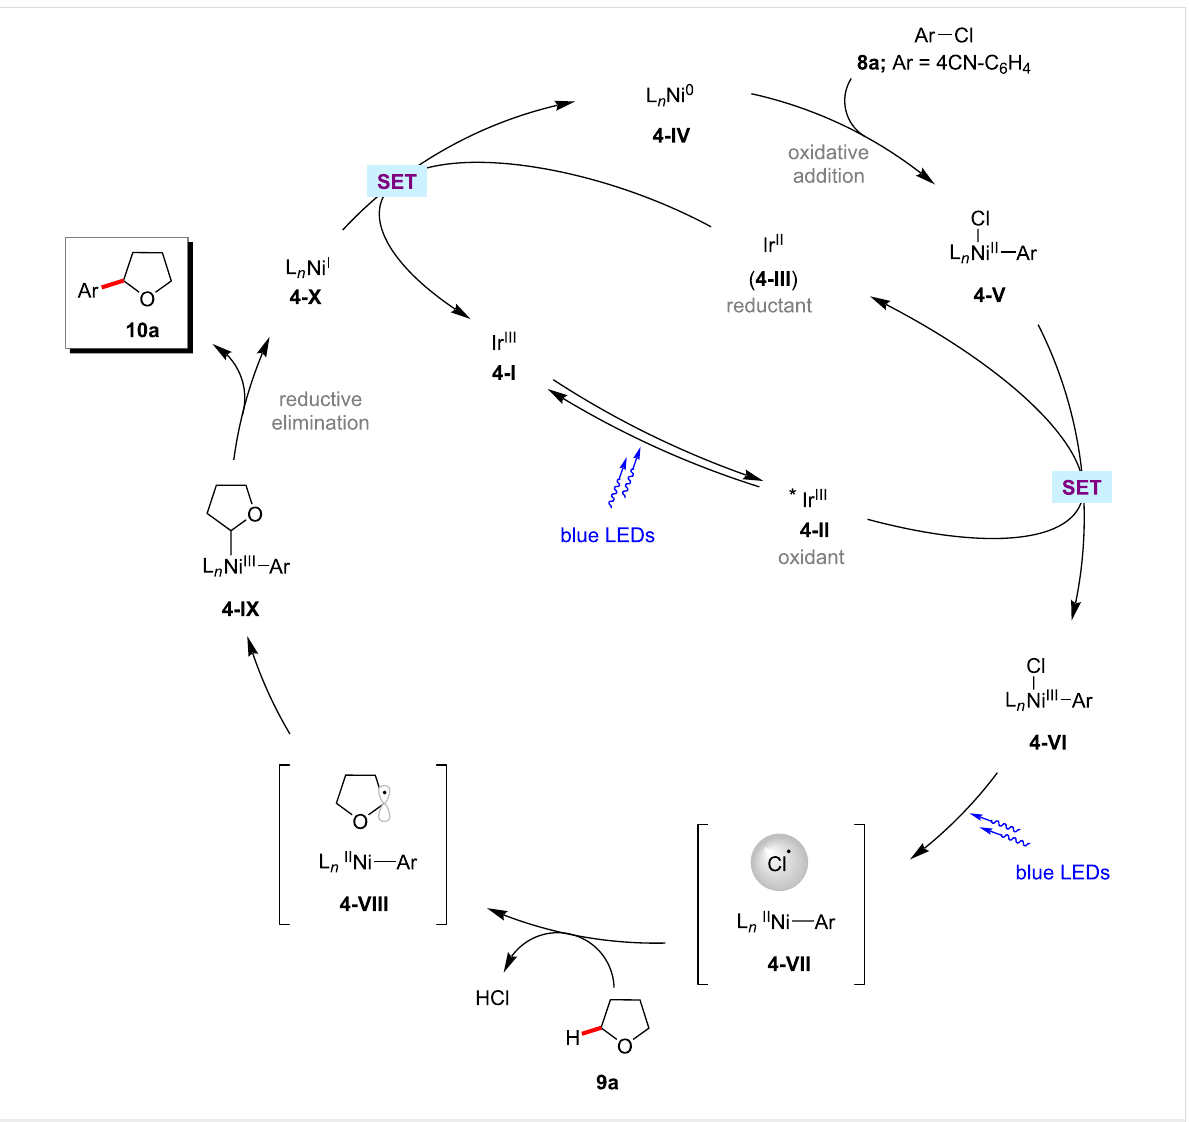
Figure 4: Proposed catalytic cycle for the C(sp 3 ) − H arylation of cyclic and acyclic ethers.